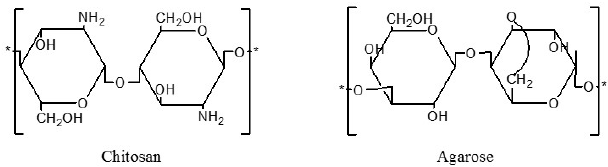
Figure 1. Chemical structures of chitosan and agarose.